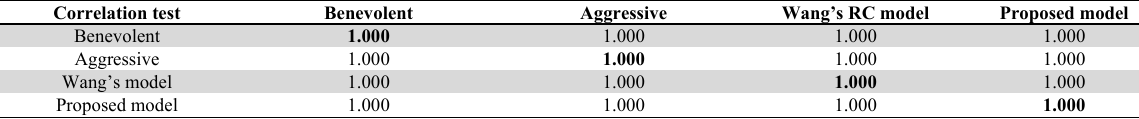
Spearman’s rank correlation test for performance assessment problem Correlation